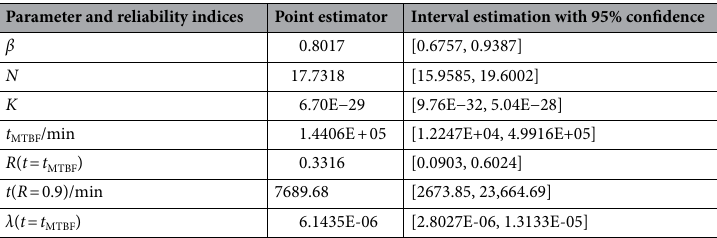
Table 4. Reliability analysis results for insulating oil.